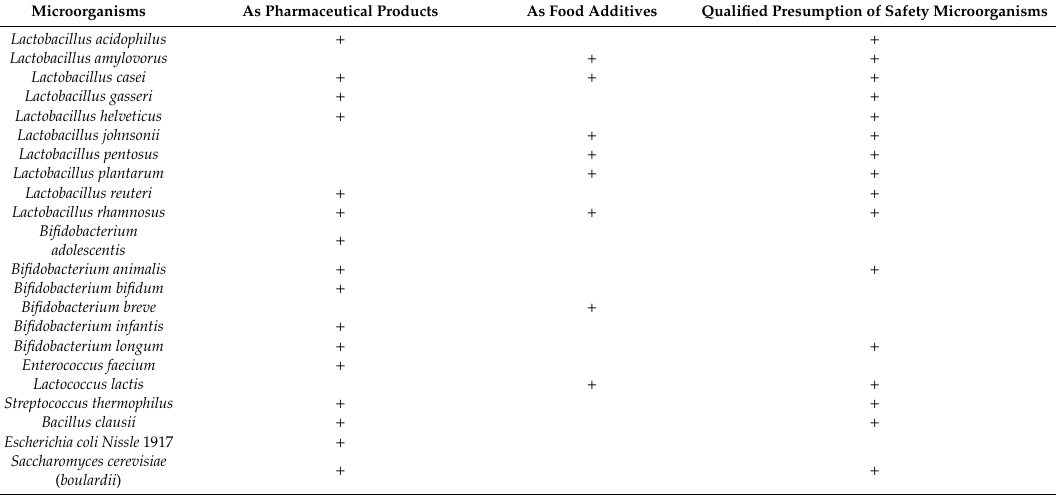
Table 2. Probiotic microorganisms used in the human pharmaceutical and nutrition field [35–37].